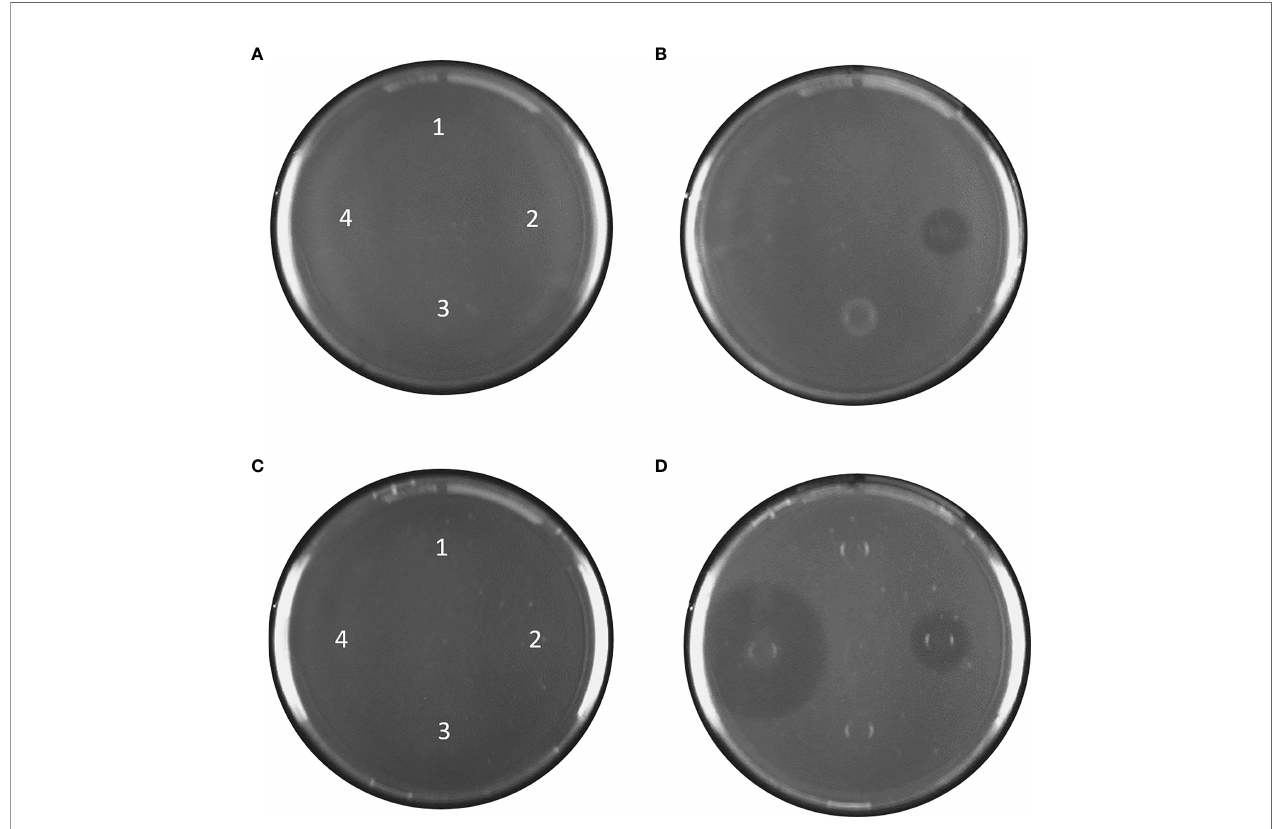
FIGURE 5 | Agar plates with BPE-RP-PLA at pH 5, ( A ) before incubation and ( B ) after 24 h at 37°C. BPE-RP-PLA plates at pH 8, ( C ) before incubation and ( D ) after 24 h at 37°C. Blank and samples applied at the indicated spots: 1) Deionized water, 2) lipase, 3) esterase, and 4) protease. After 24 h at 37°C, clear zones are visible for lipase at pH 5 ( B ) and for lipase and protease at pH 8 ( D ). The contrast of the images was increased by 25% to emphasize the clear